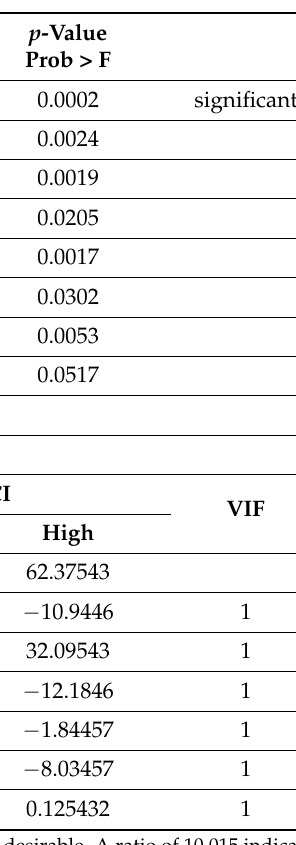
Table 4. Regression statistics and analysis of variance (ANOVA) for Placket-Burman